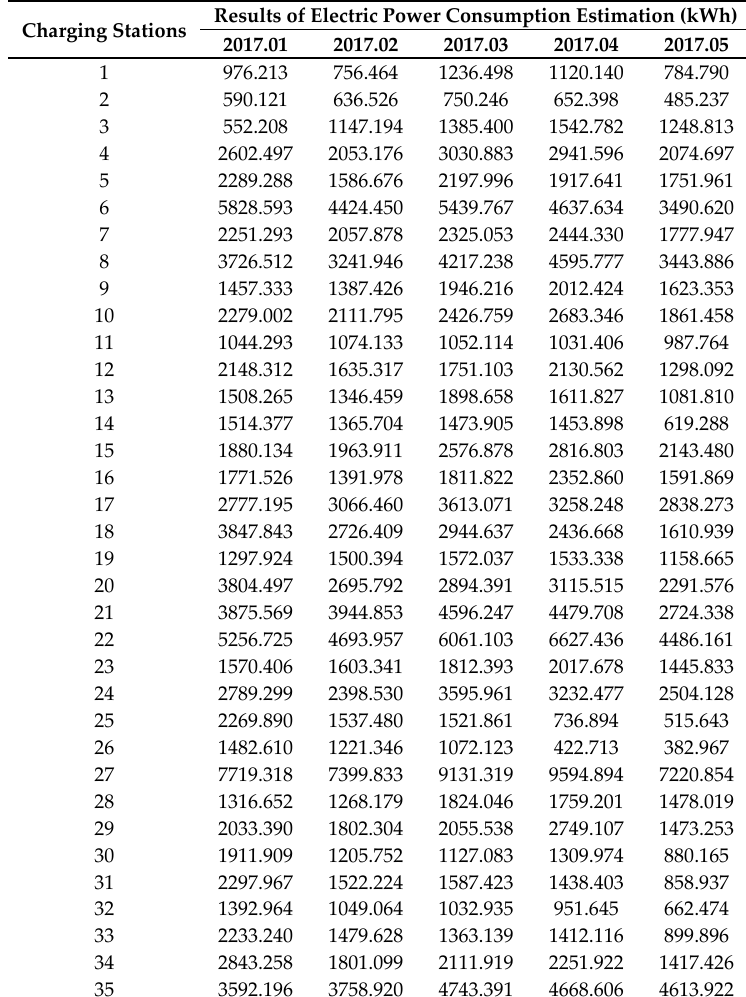
Table 3. Results of electric power consumption estimation of charging stations on Jeju island applying the EV charging power consumption regression